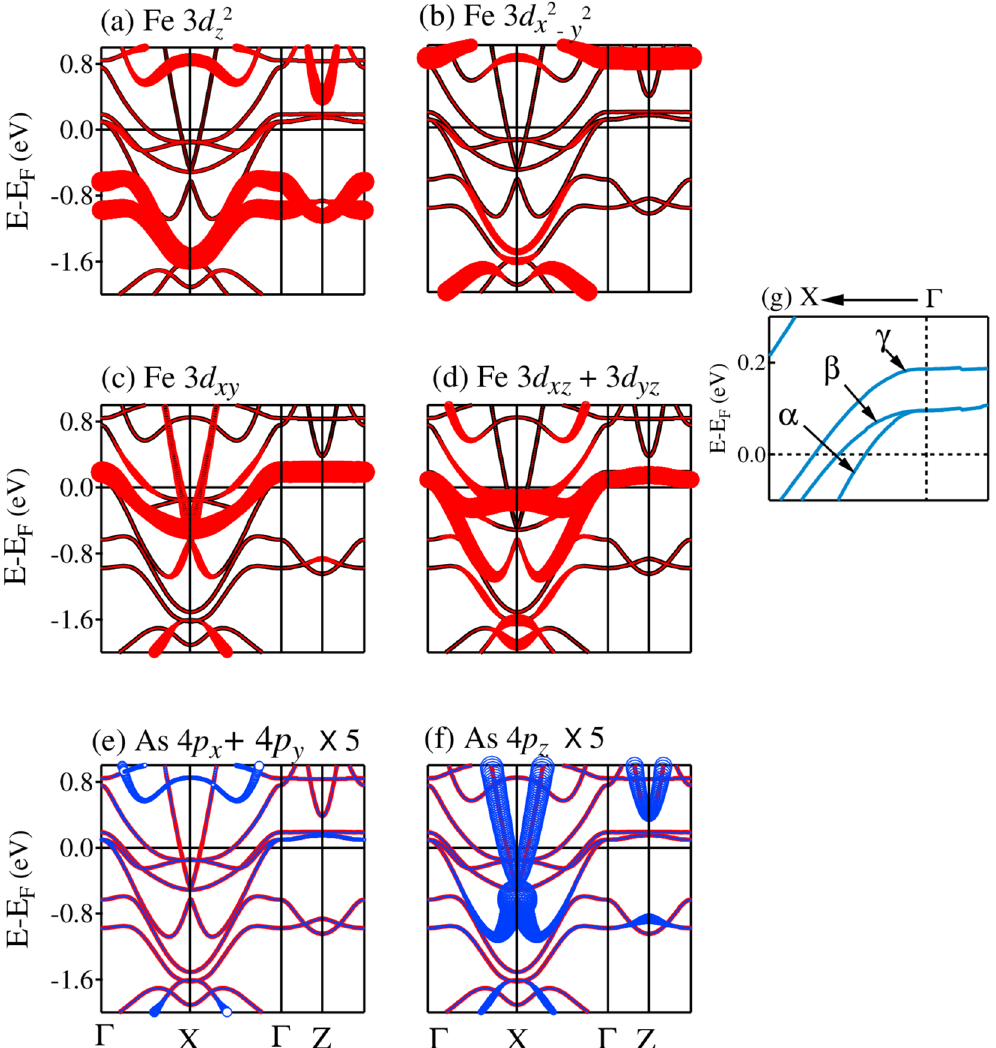
Figure 15. Energy bands of tetragonal CaFe 2 As 2 near the Fermi level. The thickness of the lines exhibit ( a ) Fe , ( c ) Fe 3 d xy , ( d ) Fe (3 d xz + 3 d yz ), ( e ) As (4 p x + 4 p y ), ( f ) As 4 p z characters. ( g ) Energy bands d 3 z 2 , ( b ) Fe − d 3 x y 2 2 along Γ − X direction in a highly expanded energy scale to distinguish them with clarity. The bands are defined as α , β and γ